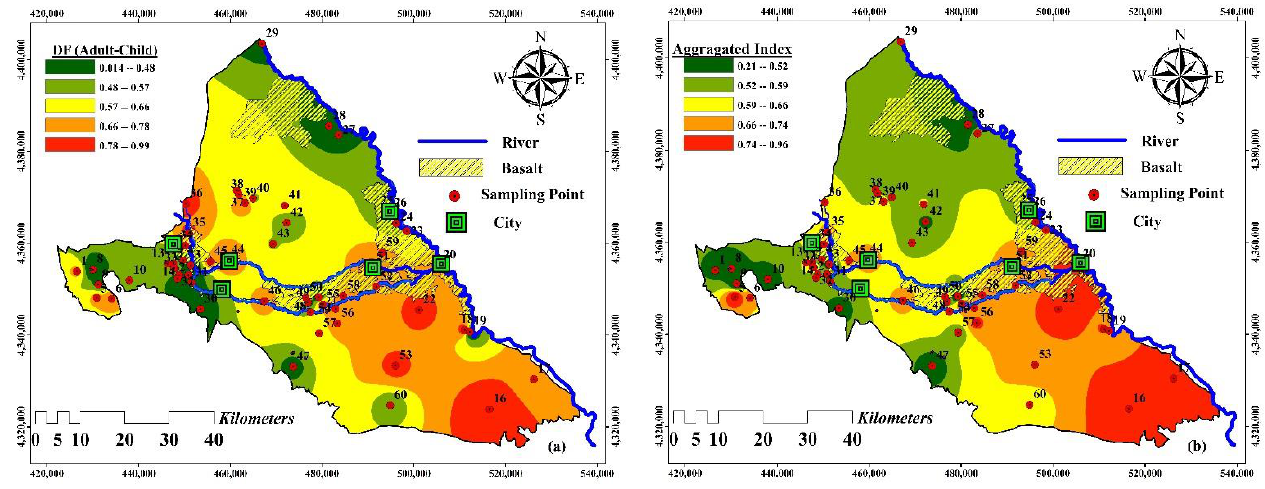
Figure 9. Spatial distribution ( a ) data fusion of HHRI results (Strategy 1); ( b ) comprehensive risk maps (Strategy 2).